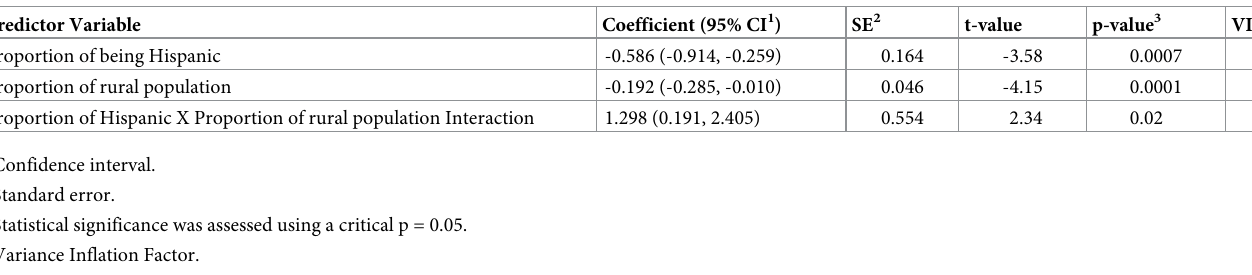
Table 6. Results of ordinary least square regression model showing predictors of Diabetes Self-management Education (DSME) participation rates at the county level in Florida,